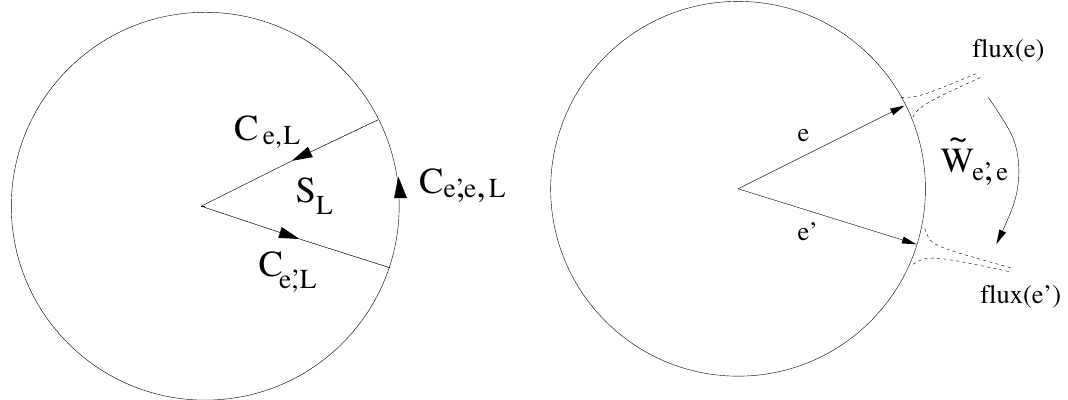
Figure 2. f W e 0 ; e as a string-local (cid:13)ux-carrying